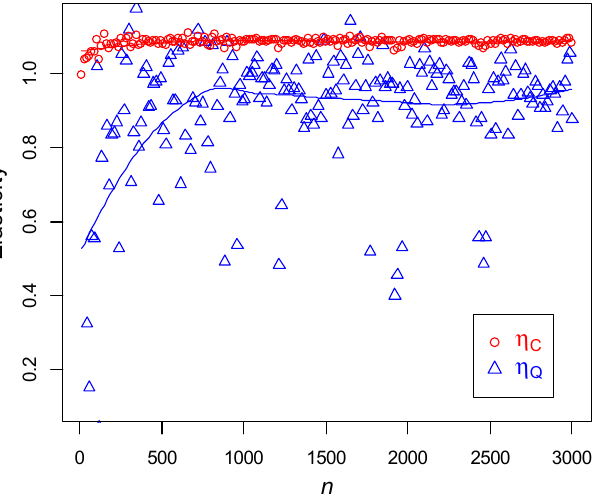
Figure 17. Variation of elasticity indices η Q and η C for the Min River vary with increasing n .